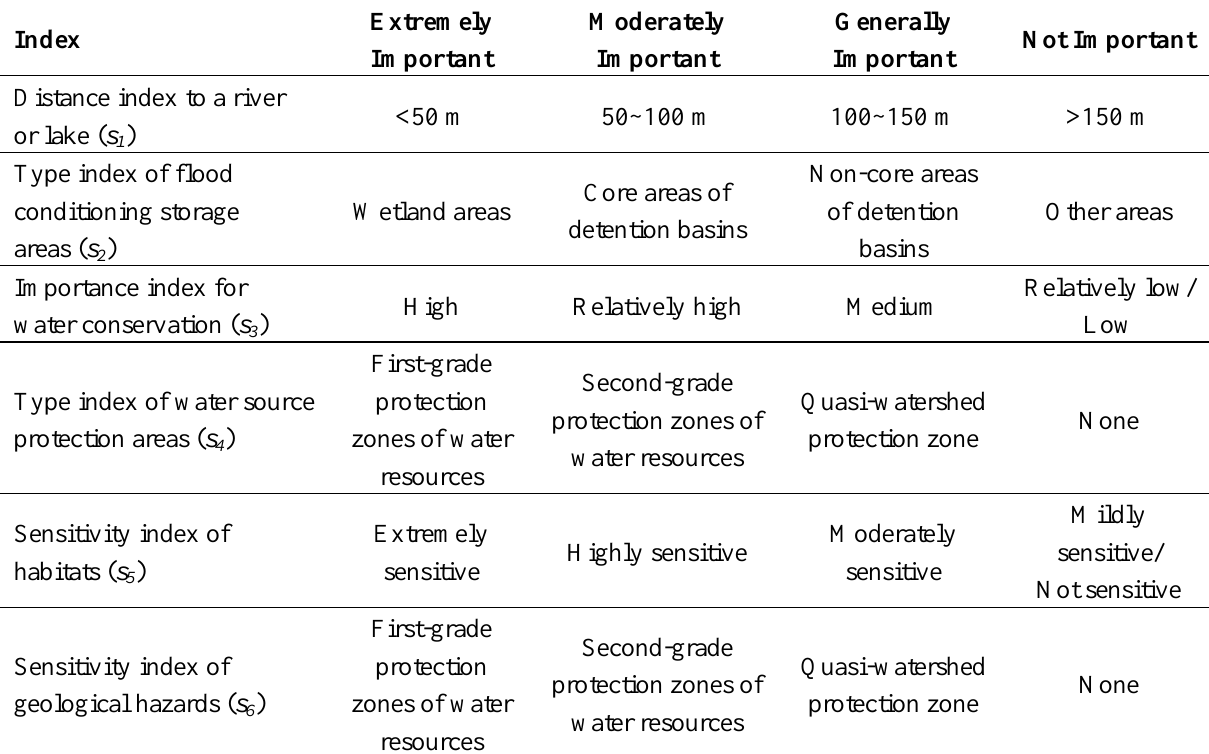
4. Ranking criteria and assigned scores for the indexes of